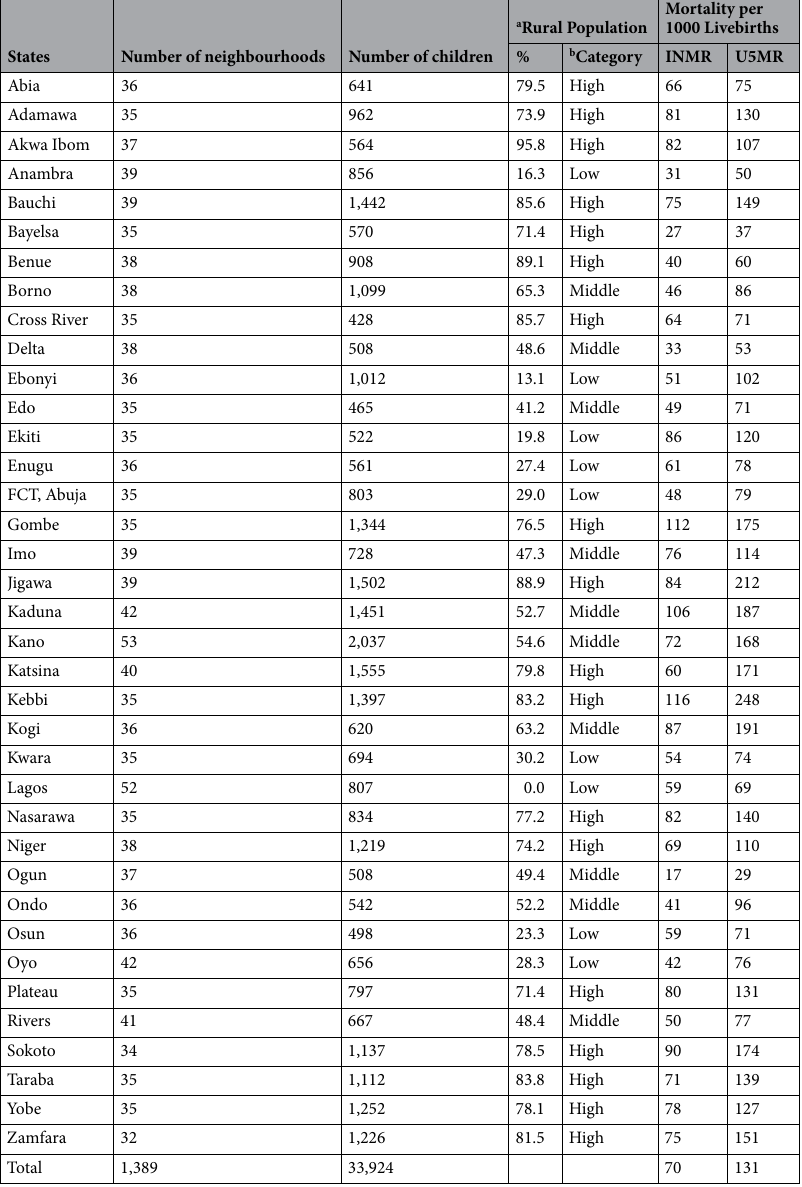
Table 2. Distribution of children aged 0–59 months, infant mortality and under-five mortality by states in Nigeria. a Percent rural forecast in 2017 14 ; b Low (0–33.3%); Middle (33.4 to 66.7%) High (66.8 to 100%); INMR Infant Mortality Rate, U5MR Under-five Mortality